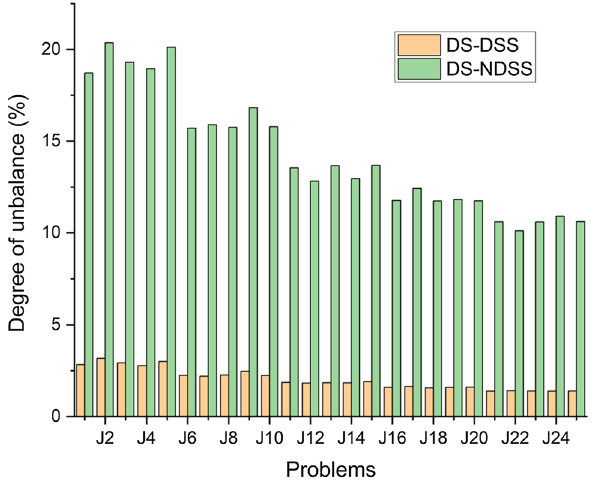
Fig. 11 The average makespan of DS-DSS and DS-NDSS